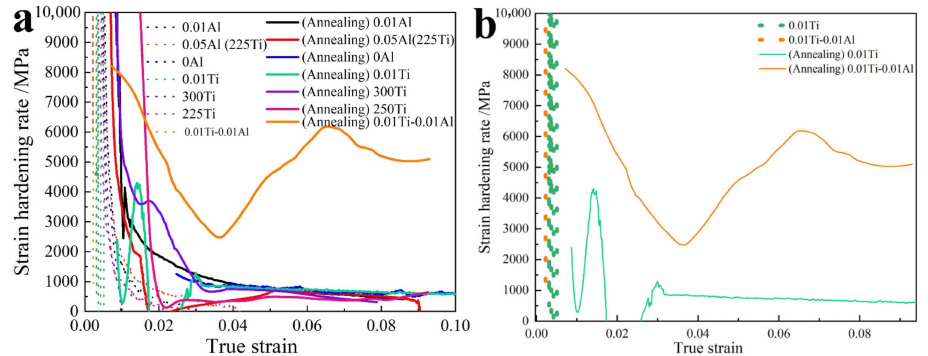
Figure 9. Curves of strain-hardening rate and true strain of the rolled sheets: ( a ) different Mg-(Al-)Ti rolled sheets and their annealing sheets; ( b ) Mg-0.01Ti-0.01Al (0.01Ti-0.01Al) and Mg-0.01Ti- (0.01Ti) rolled